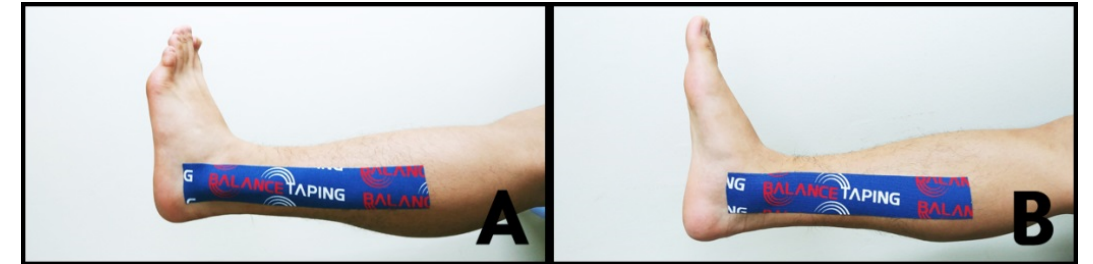
Figure 4. Ankle placebo taping (APT): ( A ) taping was applied from below the medial malleolus to half of the area below the inner knee; ( B ) taping was applied from below the lateral malleolus to half of the area below the outer knee.